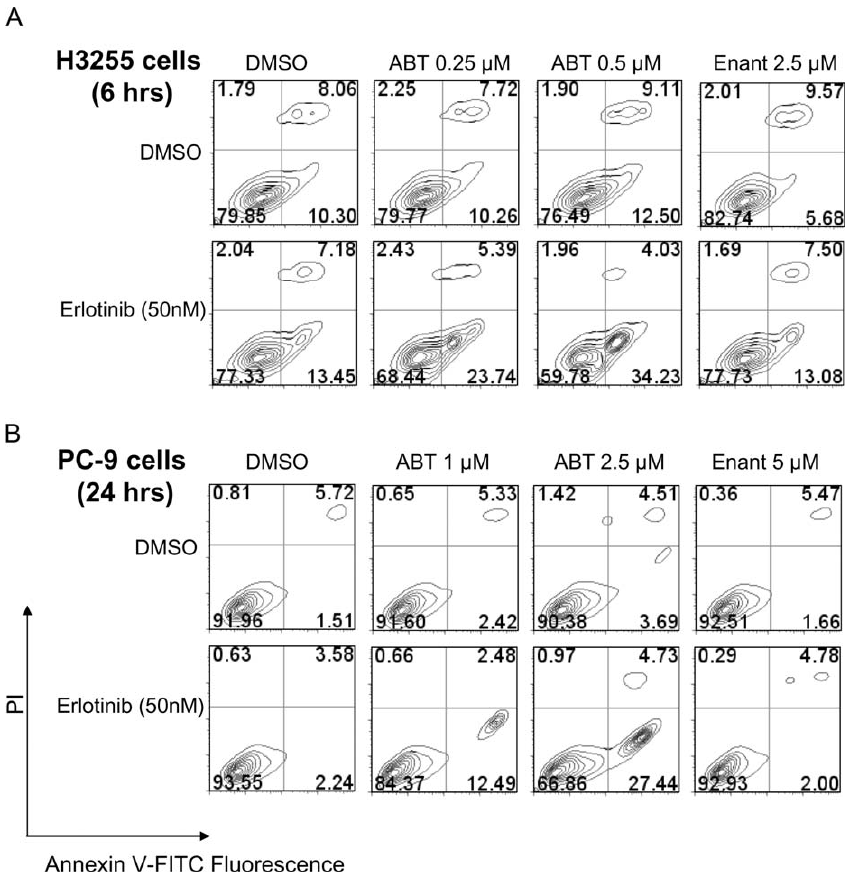
Figure 8. ABT-737 Significantly Enhances Erlotinib-Induced Apoptosis in Drug-Sensitive Lung Adenocarcinoma Cells (A) H3255 cells were cotreated with 50 nM erlotinib and different concentrations of ABT-737 for 6 h. The percentage of apoptotic cells for each drug combination was determined by annexin V/PI apoptosis assays. (B) PC-9 cells were cotreated with 50 nM erlotinib and different concentrations of ABT-737 for 24 h. The percentage of apoptotic cells for each drug combination was determined by annexin V/PI apoptosis assays. The enantiomer of ABT-737 was used a negative control. ABT, ABT-737;